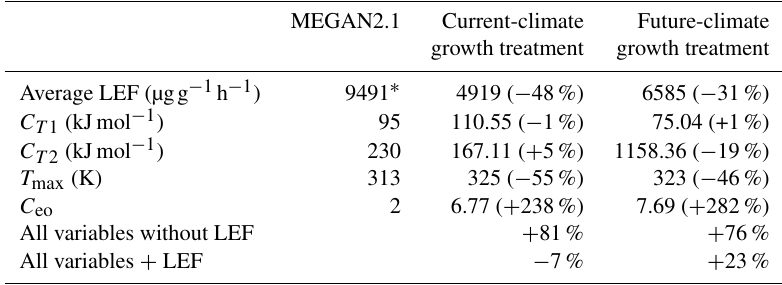
Table 3. Changes to MEGAN variables based on fitted data from current- and future-climate growth experiments. Percentages in brackets indicate change in maximum daily isoprene emissions due to change in variable.